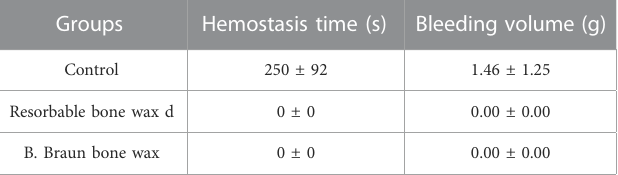
TABLE 2 Hemostasis time and bleeding volume of